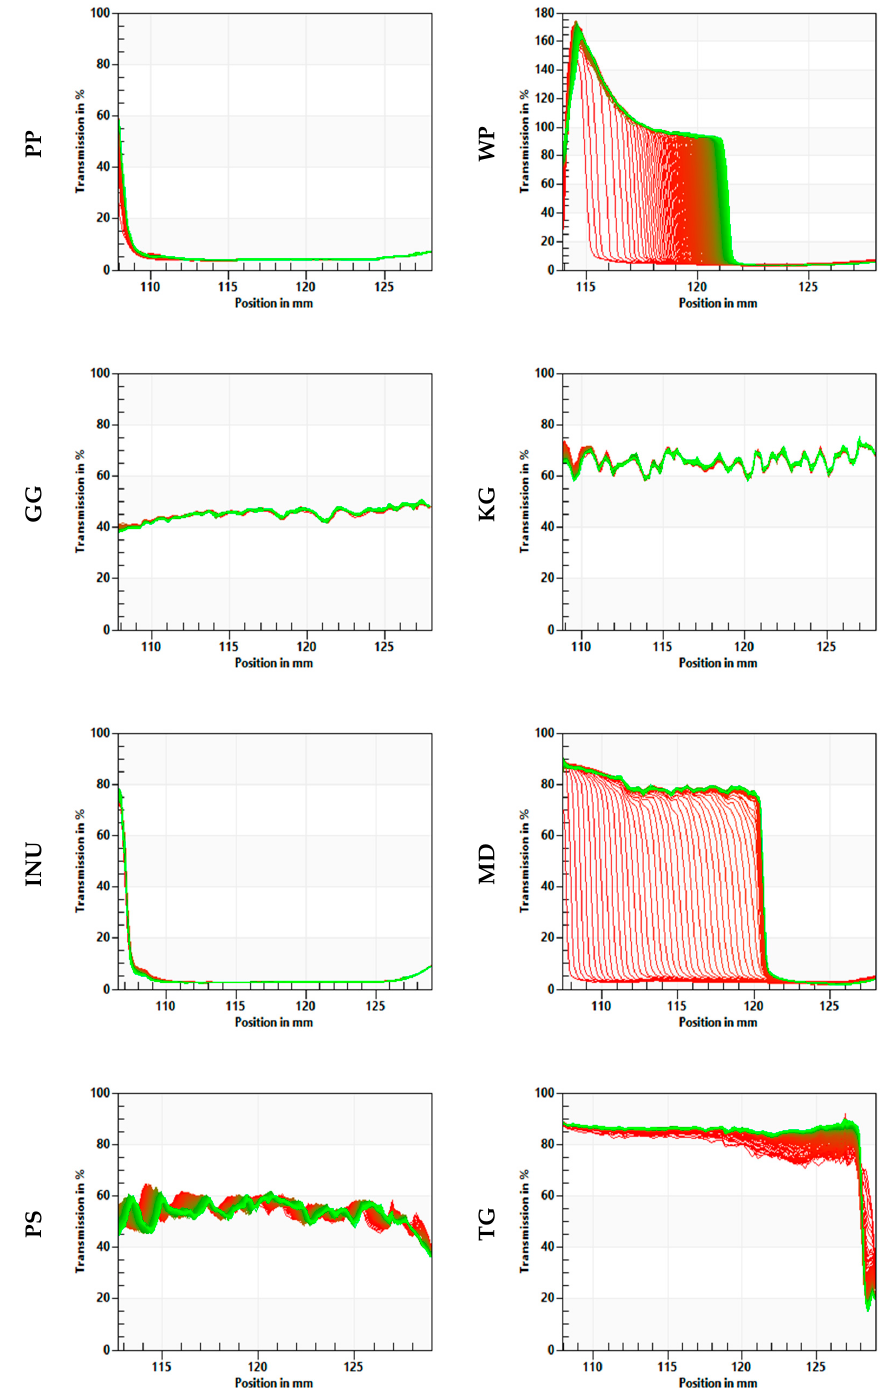
Figure 4. Evolution of transmission profiles (“fingerprints”) of the analyzed biopolymers. The red lines represent the extinction profiles of the sample at the beginning of the analysis and the green lines at the end of the analysis (STEP technology - space and time resolved extinction profiles).